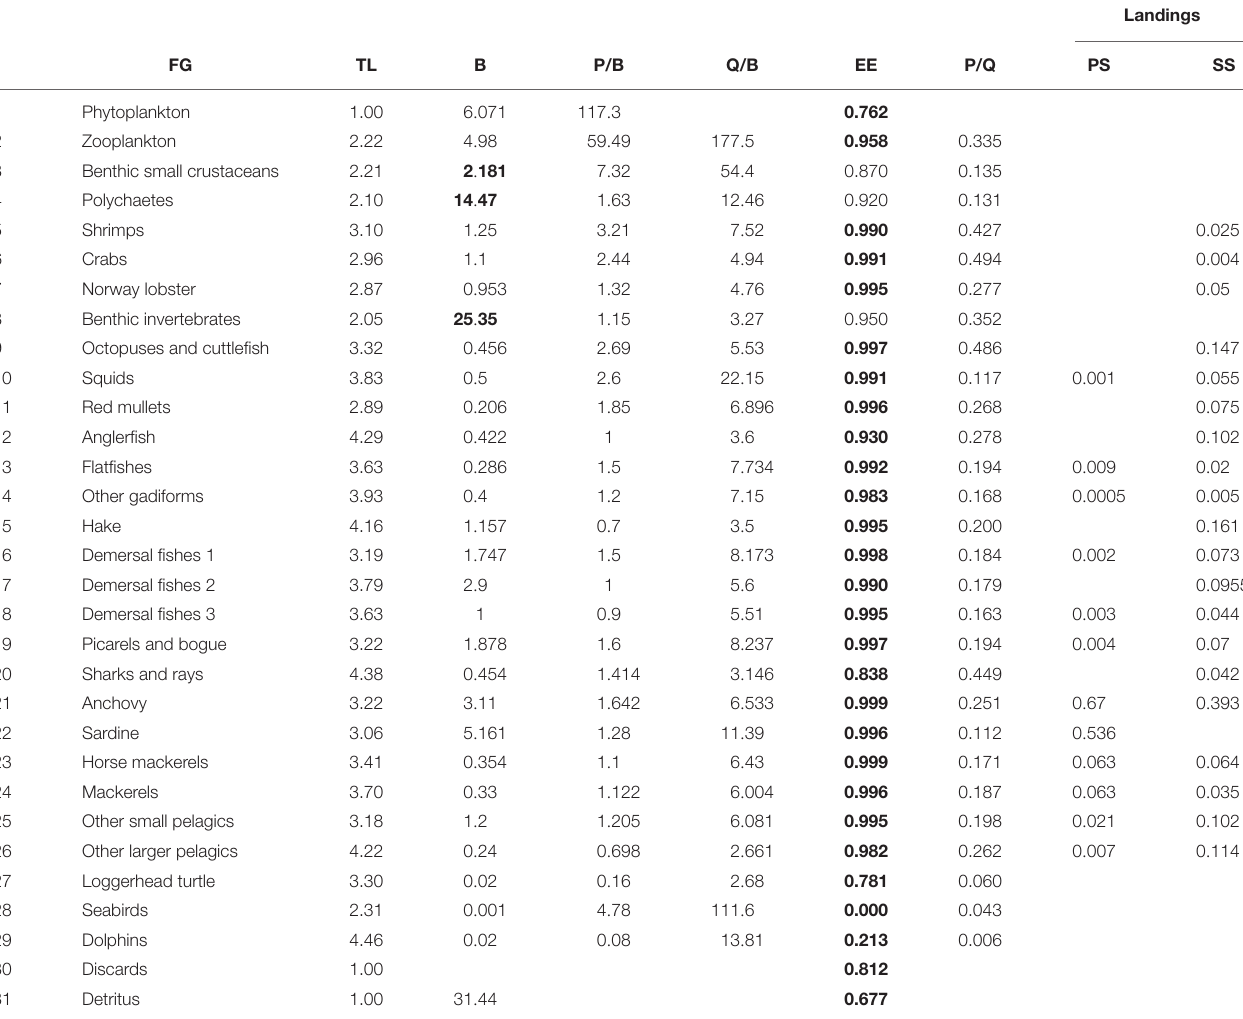
TABLE 2 | Input and output (bold) parameters of the Pagasitikos Gulf Ecopath